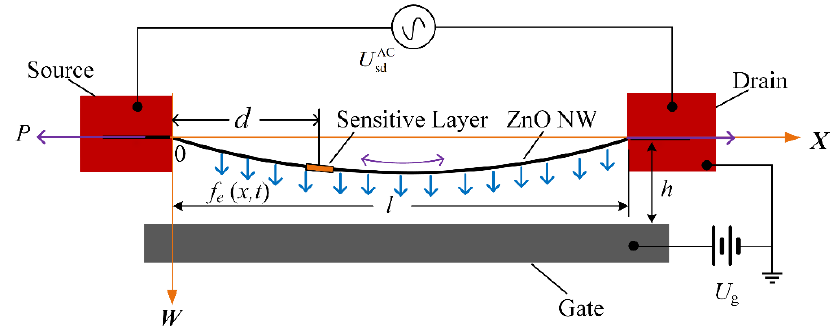
Figure 1. Forced vibration model of the ZnO NW sensor.